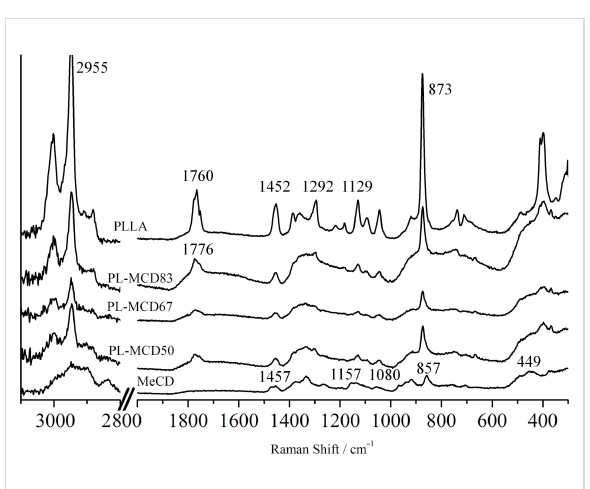
istic peaks for PLLA are at 2955 cm − 1 ( ν CH), 1760 cm − 1 ( ν C=O), 1452 cm − 1 ( δ CH 3 ), 1292 cm − 1 ( δ CH), and 873 cm − 1 ( ν C-C α ) [51,52]. Peaks at 857 and 449 cm − 1 are characteristic for MeCD [53].